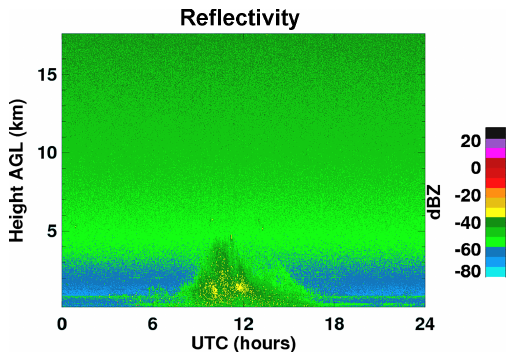
Figure A1. KAZR reflectivity on 29 January 2014 at the SACOL, indicating a dust event. The morphology and power level of the re- turn signal are not apparent for a cloud from the surface to the height of 5km between 08:00 and